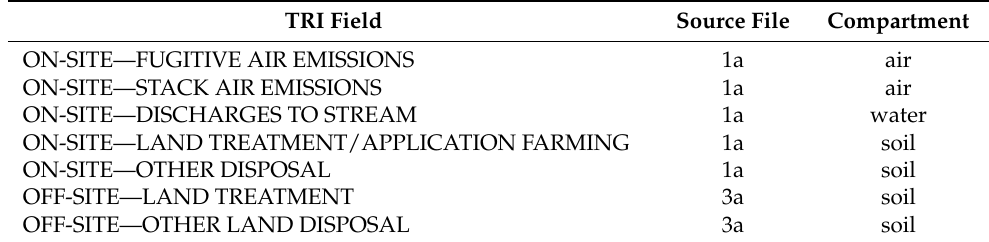
Table 4. TRI release types tracked by stewi